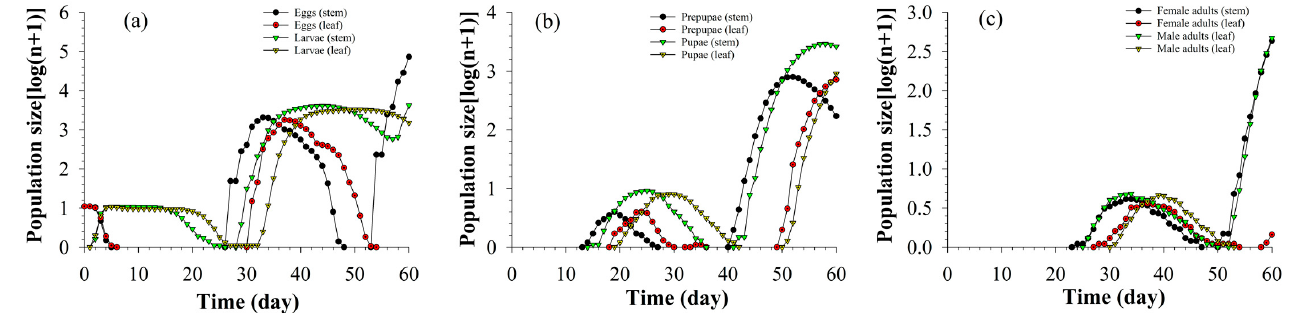
Figure 6. Population projection of each insect stage of eggs and larvae ( a ), prepupae and pupae ( b ), female adults and male adults ( c ) of S. litura fed on different tissues of asparagus.